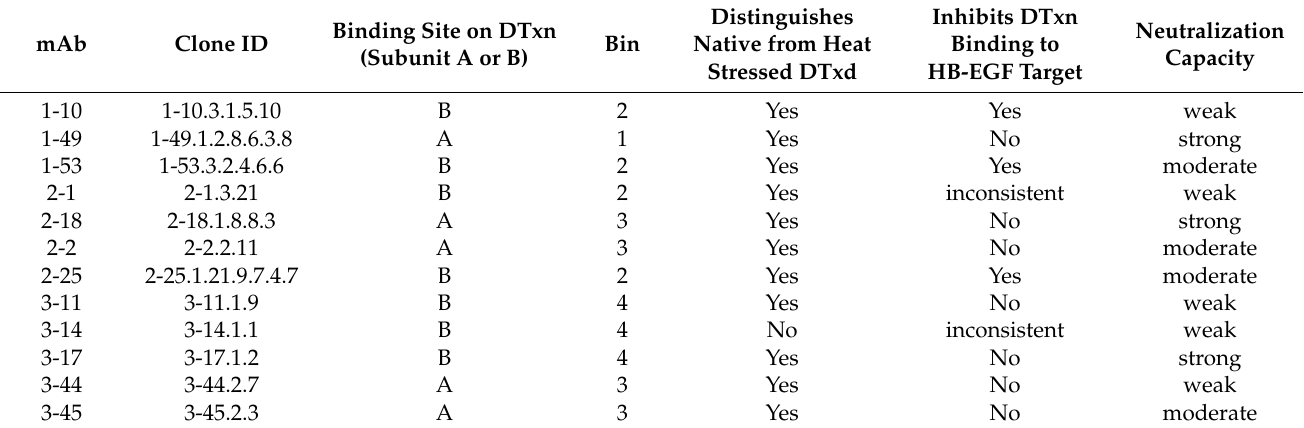
Table 1. Characterization summary of 12 anti-DTxd monoclonal